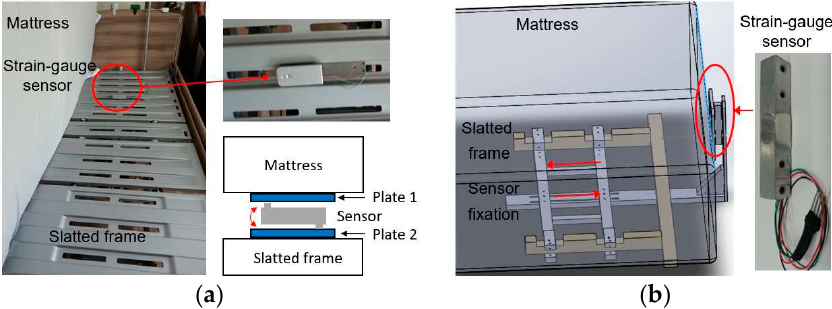
Figure 2. Measurement setups and sensor locations: ( a ) below the mattress and ( b ) head of the mattress.